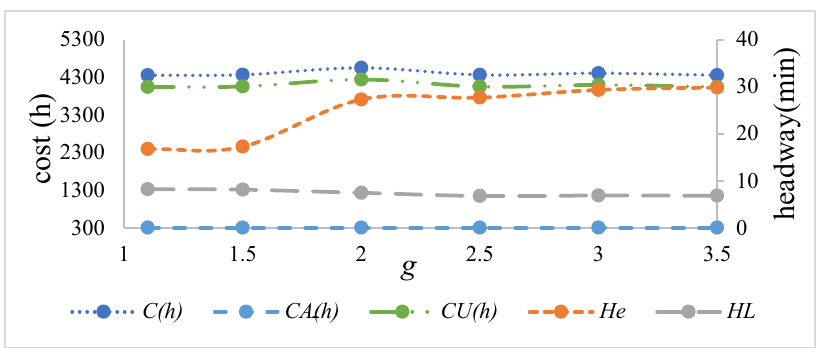
Figure 4. The variations in the objective function and decision variables with changes to g .